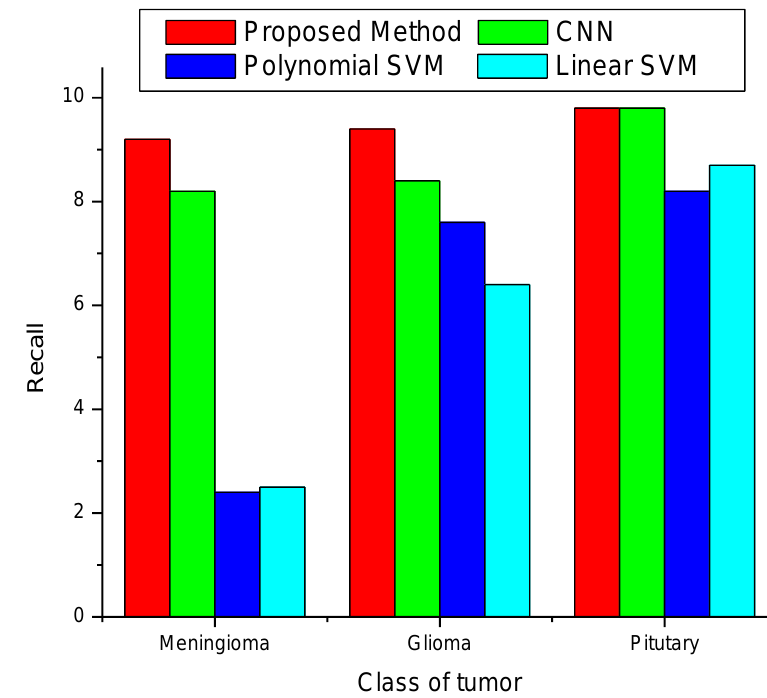
Figure 9. Precision of classification method.